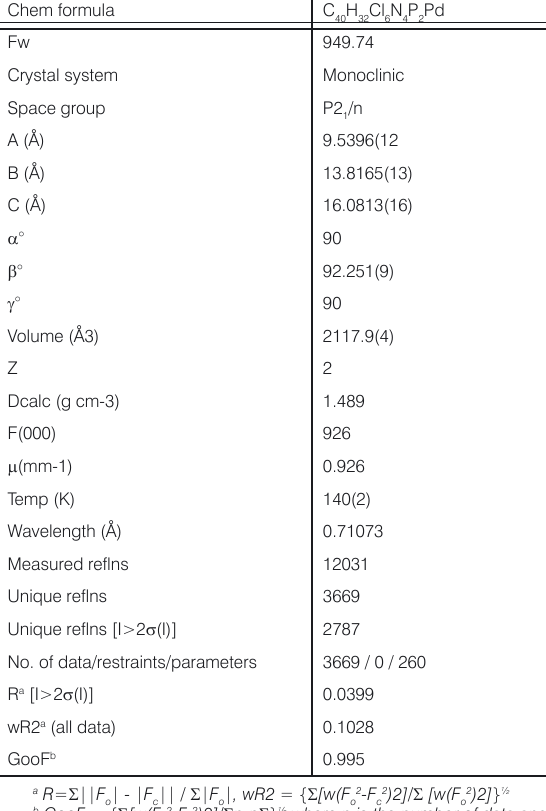
Scheme 1. Synthesis of the complexes 2 and 3